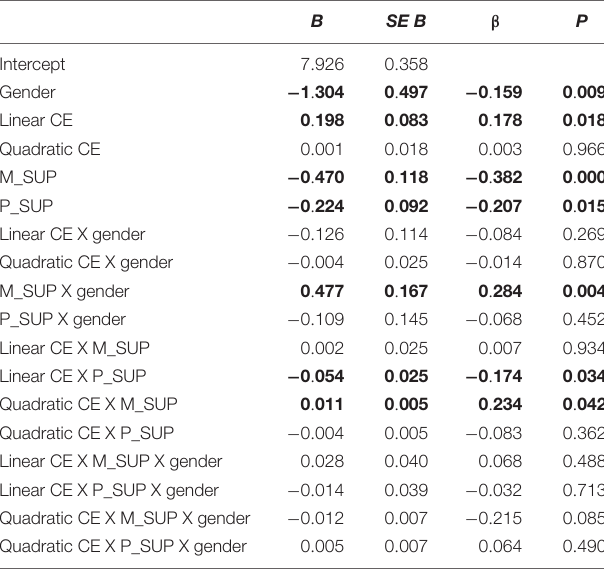
TABLE 4 | Multiple regression analysis with moderating effects of maternal support, paternal support, and gender on the relationship between cognitive empathy (linear and quadratic) and depression.